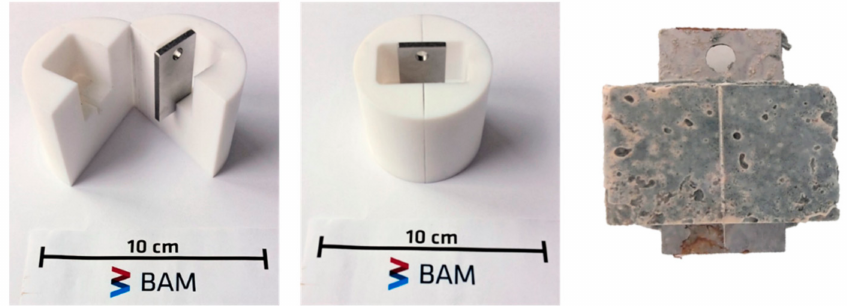
Figure 2. A home-made PTFE mold for embedding steel coupons in mortar and (right side) a 1.8977/Variodur specimen after hydrating for 28 days. A hole was made on each steel coupon to allow hanging of the specimen inside the